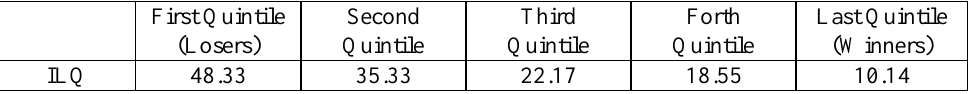
Table (5): Liquidity and Momentum Portfolios